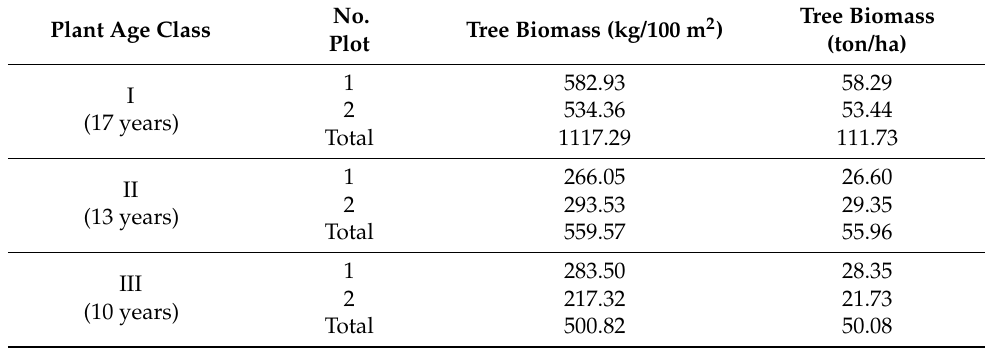
Table 1. The average amounts of biomass stored in D. polyphylla trees for 3 age classes. Plant Age